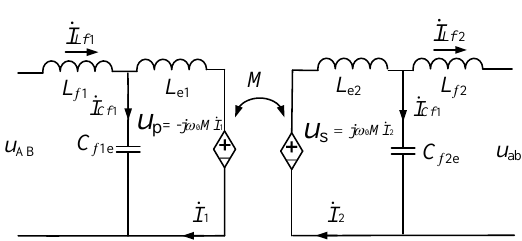
Figure 4. Equivalent circuit of LCC compensation topology network.